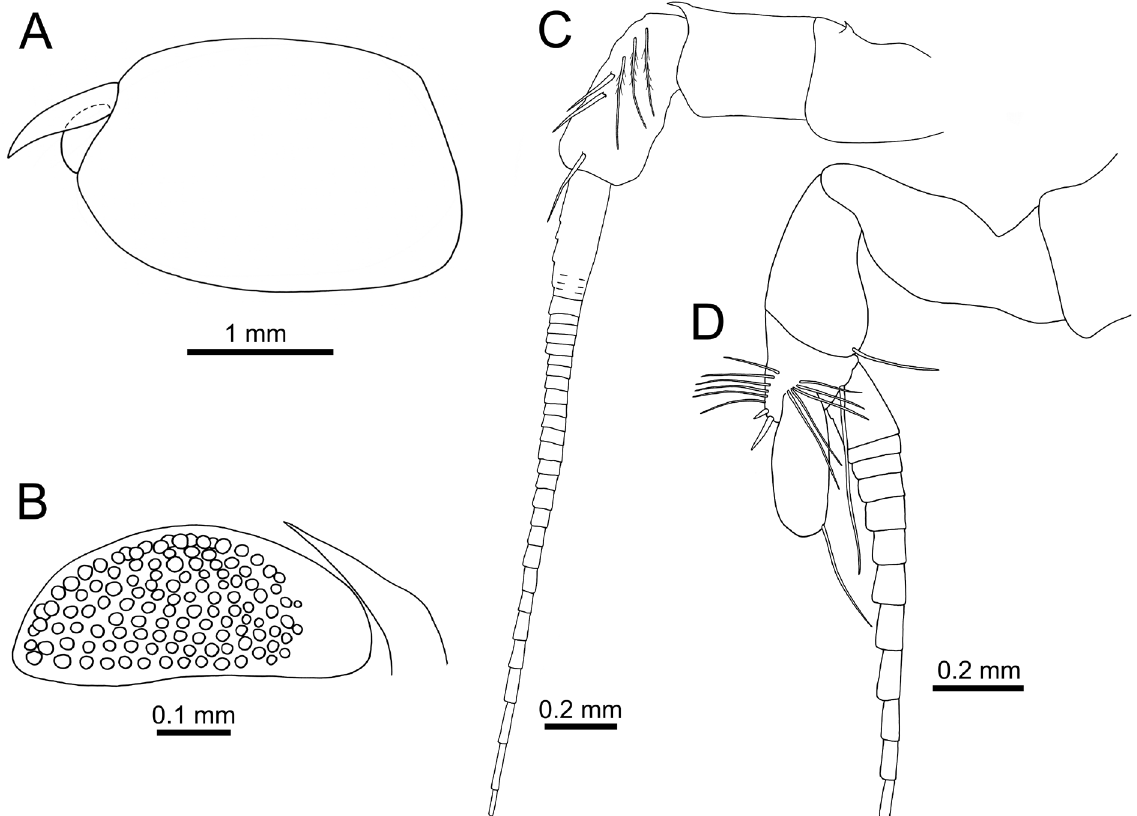
Fig. 5. Nebalia strausi Risso, 1826. Male (DBUA0001677.01.W). A . Rostrum, eye and carapace outline, lateral view. B . Eye and supra-orbital plate, lateral view. C . Antenna, lateral view. D . Antennule, lateral view. C–D: only selected setae